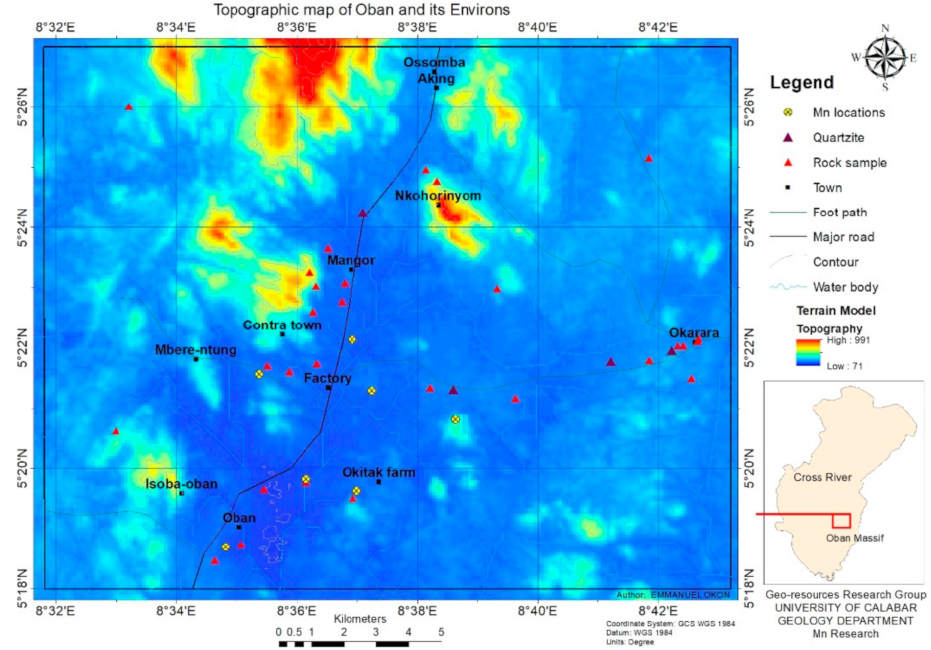
Figure 2. Topographic map of the study area showing the major towns, sample locations, and Mn occurrences (Prepared by